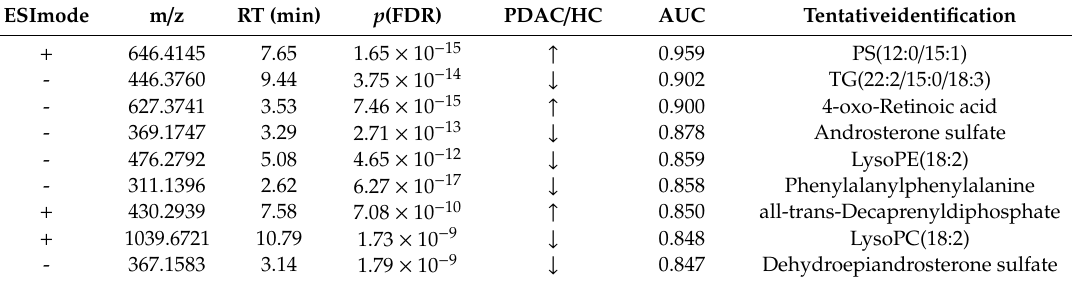
Table 3. Selected candidate markers to create the proposed multivariate